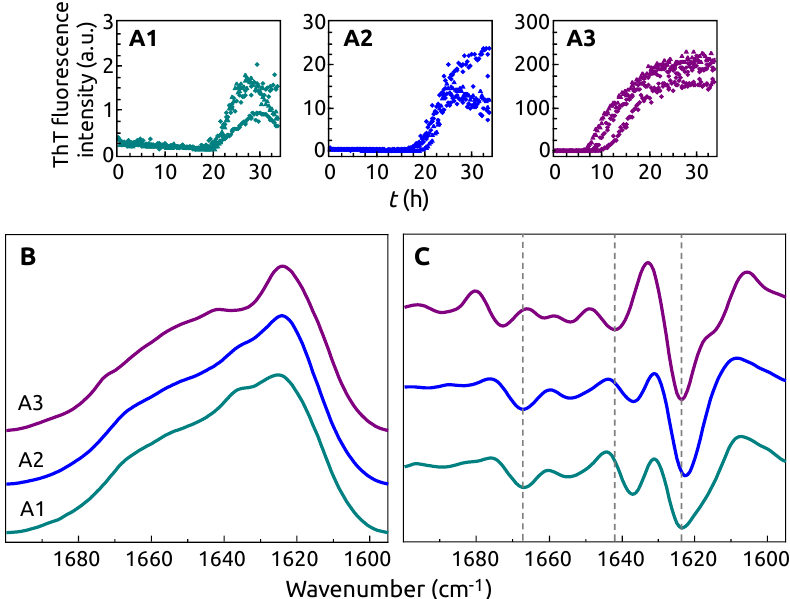
Figure A3. Aggregation kinetics ( A1 – A3 ), FTIR spectra ( B ) and second derivatives ( C ) of α -syn populations (indicated by A1 – A3 ), when α -syn was aggregated in the presence of 70µM lysozyme monomers. All aggregation conditions were identical to the ones during α -syn aggregation with 70µM S100A9, as described in the Materials and Methods